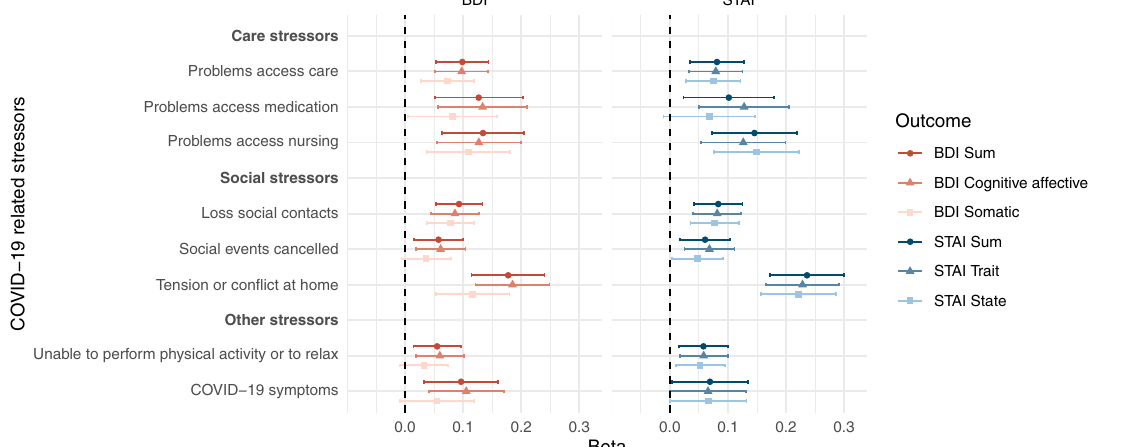
Fig. 1 Association between COVID-19 related stressors and depressive and anxiety symptoms. Points represent the regression coef fi cients of the linear models and bars the 95% con fi dence intervals. The BDI, STAI, and their respective sub scores were standardized in order to make the estimates comparable. Models were adjusted for sex, age, disease duration, presence of comorbidities, education, living situation, region and date. N = 844.